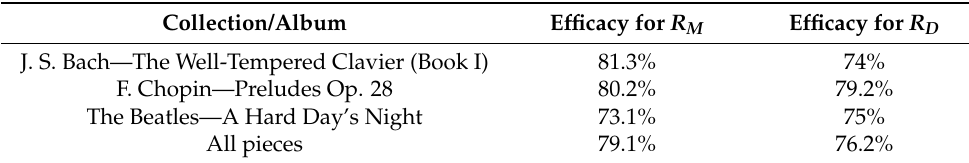
Table 3. Overall * efficacies of the key detection obtained for different weighted pitch-class represen- tations of analyzed fragments of music using a strictly correlational approach based on Krumhansl– Kessler’s profiles (K-K), where R M —the multiplicities of occurrences of individual pitch-classes; R D —the aggregate durations of individual